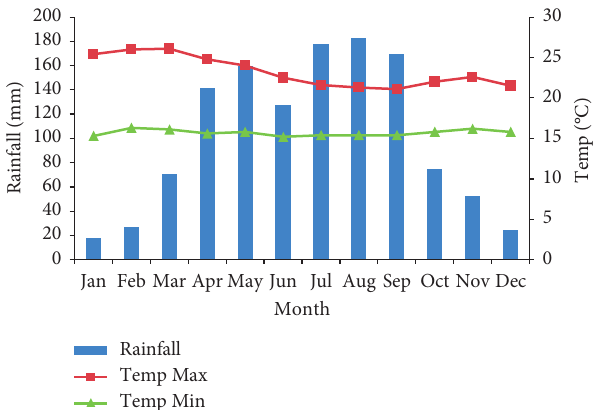
Figure 2: Nine years (2007–2015) mean monthly rainfall and mean maximum and minimum temperatures of the study areas [9].